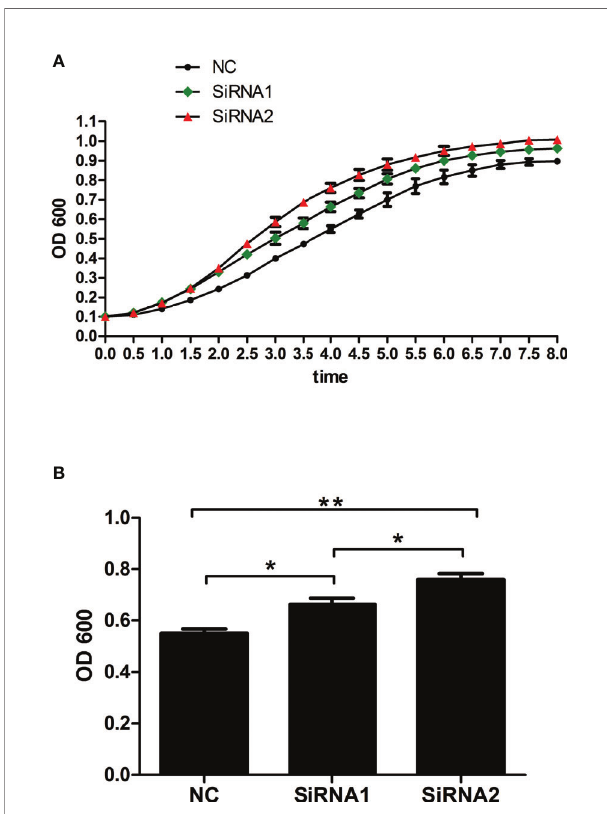
FIGURE 9 | Antibacterial activity of haemolymph supernatant from samples after PpMitf RNAi. (A) Growth curves of E. coli exposed to haemolymph supernatants of NC, siRNA1 and siRNA2 groups. (B) OD600 value of E. coli at T50 in different groups. Each value was shown as mean ± SD ( N = 5). * P < 0.05; ** P <